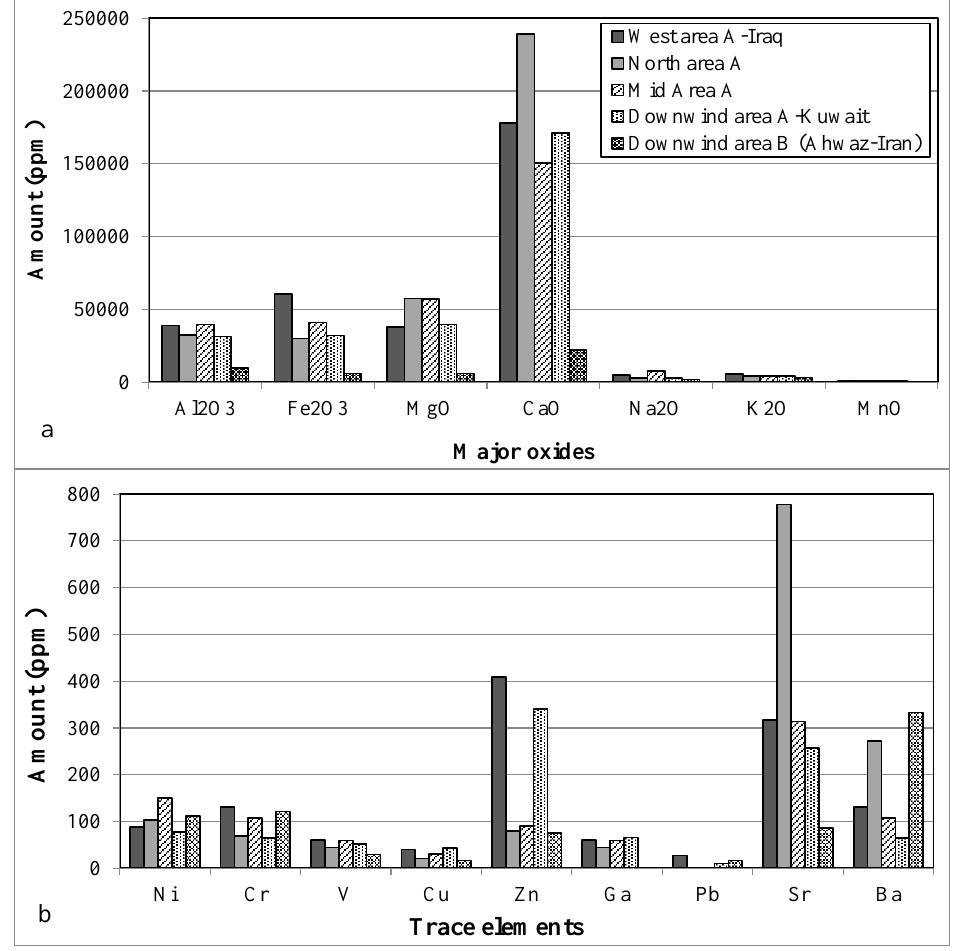
Figure 13. Average major oxides ( a ) and trace elements ( b ) for the source area (mid area A) compared to dust collected from upwind (west and north area A) and far downwind (Kuwait and Ahwaz in Iran).